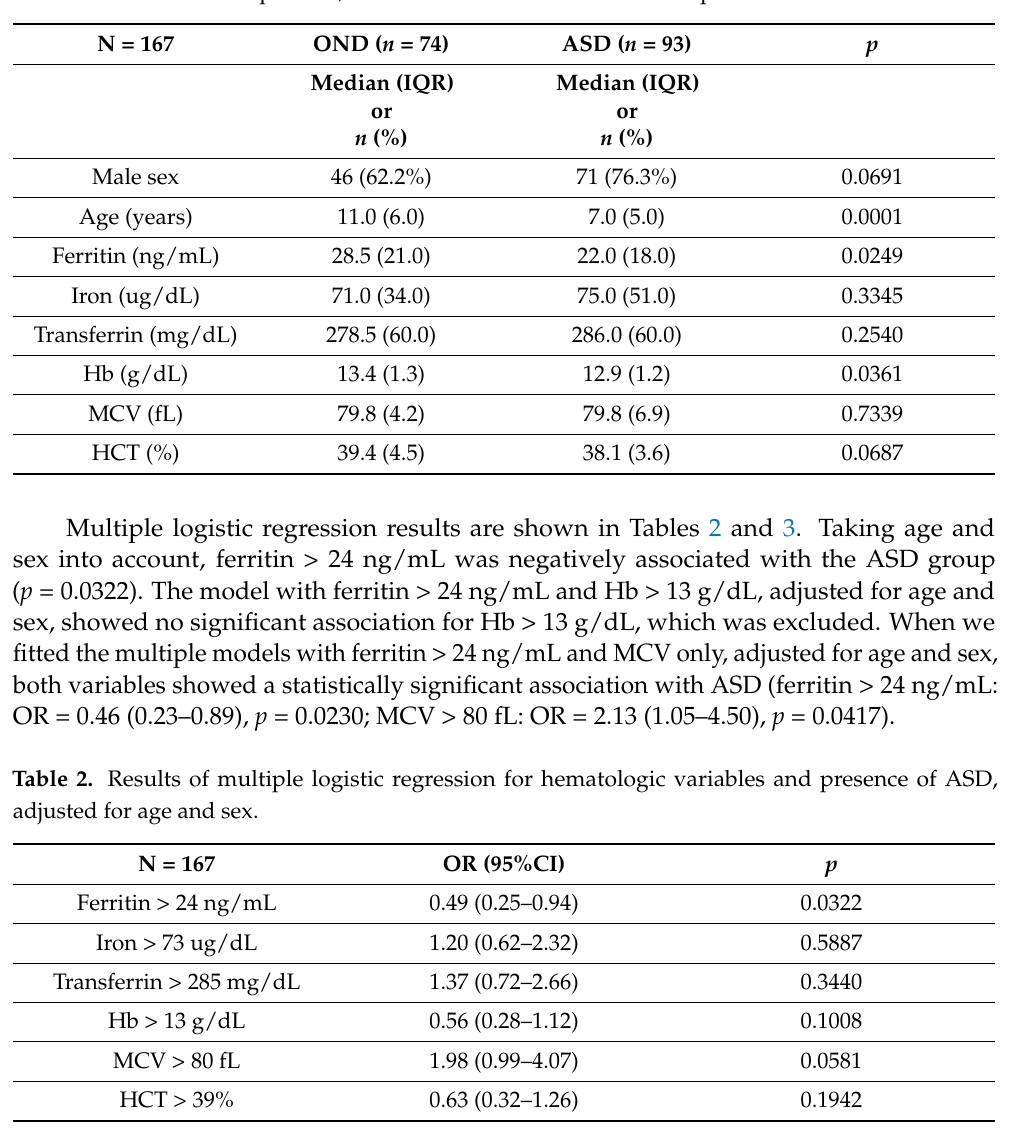
Table 1. Baseline data of patients, Wilcoxon Rank Sum test and Chi Square test.